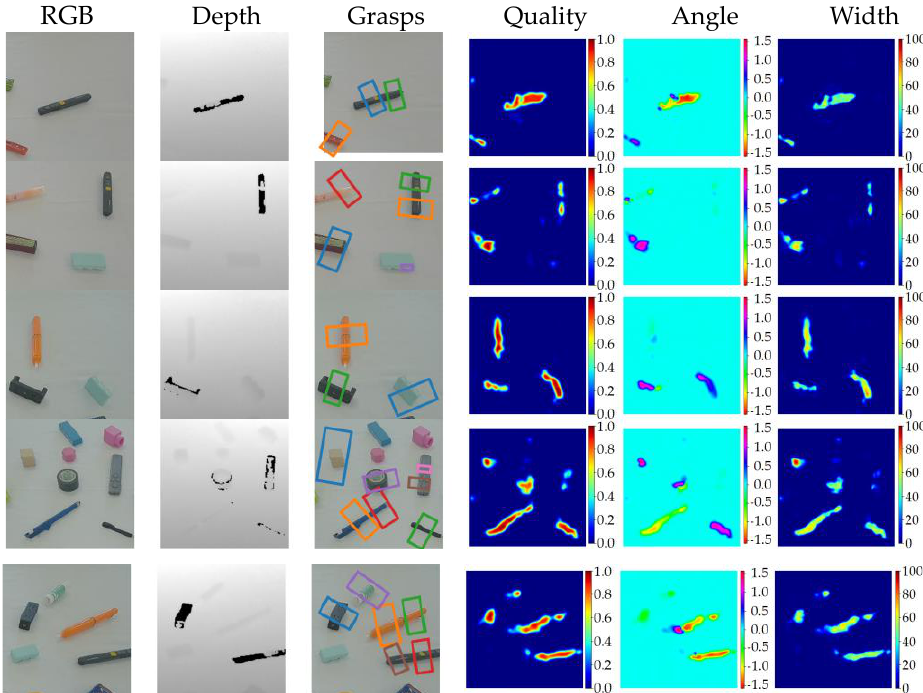
Figure 15. Detection results of the physical experiment.